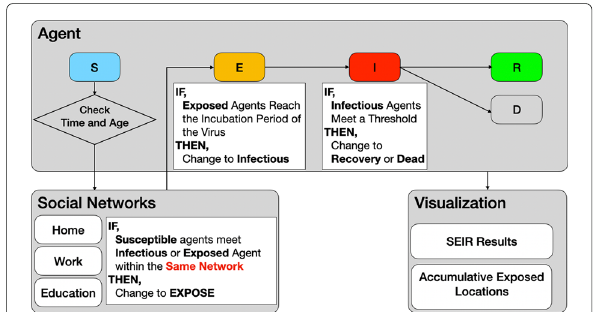
Fig. 15 Disease Model Component Structure